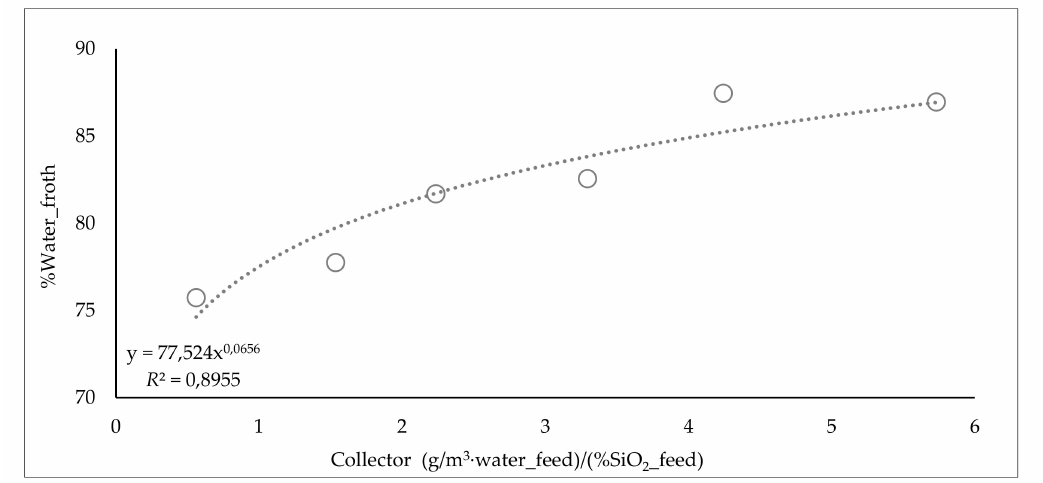
Figure 17. Trend between the amidoamine specific dosage and the %water in the froth content in the product.